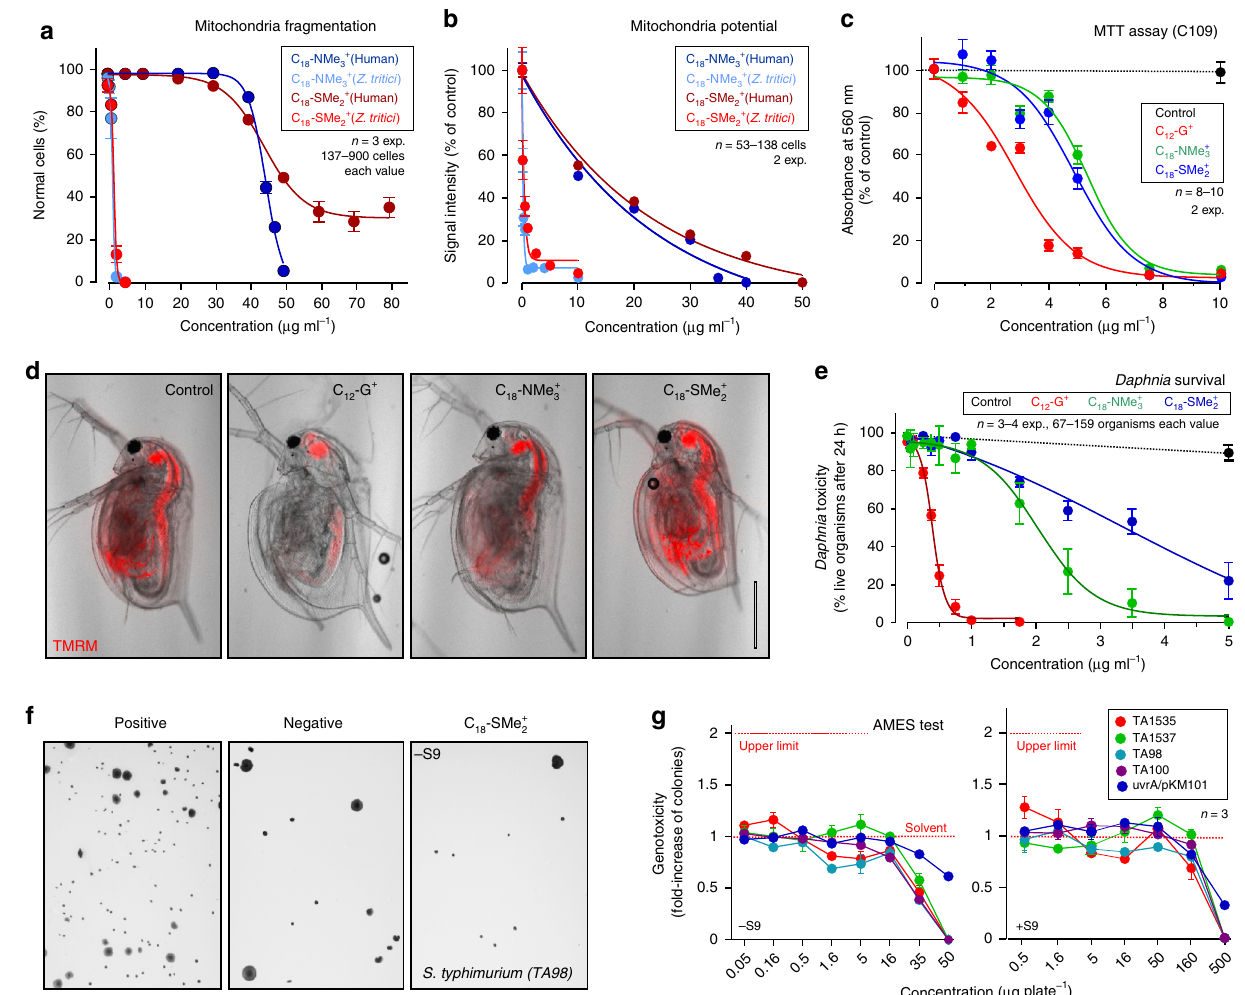
Fig. 8 Toxicity of MALCs in human C109 cells and Daphnia magna and genotoxicity of C 18 -SMe 2 + . a Concentration-dependent fragmentation of mitochondria in human C109 fi broblasts (Human) and Z. tritici cells, treated with C 18 -SMe 2 + and C 18 -NMe 3 . See Table 1 for EC 50 values. b Concentration- dependent depolarization of mitochondria in human C109 fi broblasts (Human) and Z. tritici cells, treated with C 18 -SMe 2 + and C 18 -NMe 3 + . See Table 1 for EC 50 values. c MTT test for cell viability and metabolic activity in human C109 fi broblasts, treated for 24 h with various concentrations of C 12 -G + , C 18 -SMe 2 + and C 18 -NMe 3 + . See Table 1 for EC 50 values and Supplementary Fig. 9 for MTT assay with HepG2 cells. d Mitochondrial potential, visualized by TMRM, in living Daphnia magna after incubation with solvent, C 12 -G + , C 18 -SMe 2 + , and C 18 -NMe 3 + . Note that water fl eas are still alive but immobilized for microscopy. Scale bar = 500 µ m. e Mortality in Daphnia magna after 24 h treatment with solvent (Control) and C 12 -G + , C 18 -SMe 2 + , and C 18 -NMe 3 + at various concentrations. Live water fl eas showed internal movement of gills, or heart-beat or swimming behavior. See Table 1 for EC 50 values. f Growth of mutants of the S. typhimurium genotoxicity reporter strain TA98 on agar plates supplemented with 1 µ g ml − 1 of 2-nitro fl uorene (Positive), 100 µ l of solvent dimethyl sulfoxide (Negative) and 0.1 µ g ml − 1 C 18 -SMe 2 + . Note that growth indicates a frame shift mutation that reverses the strain from auxotrophy to prototrophy. g Test for genotoxicity of C 18 -SMe 2 + at various concentrations. – S9: no metabolic activation; + S9: metabolic activation by rat liver membranes. Note that the Ames test result is considered “ negative ” ( = no mutagenic potential), if the number of prototrophic mutants stays is less than 2- fold increased (indicated by upper red dotted line). See also Supplementary Tables 4, 5. Values ( a – c , e , g ) are shown as mean ± SEM; sample sizes are indicated in graphs. Non-linear regression curves in ( a – c , e ) were calculated as dose-response inhibition (four parameters) in Prism5. See Supplementary Table 7 for experimental conditions. All source data are provided as a Source Data fi